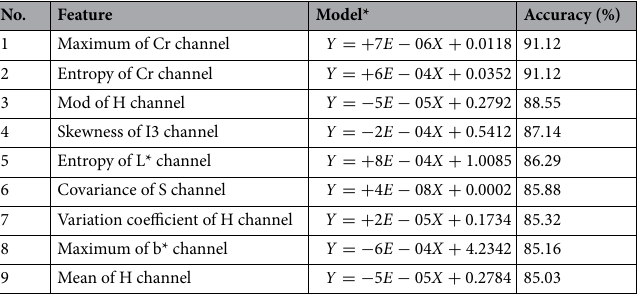
Table 1. Single variable models and their predictive accuracy. *Y is the dust concentration and X is feature.